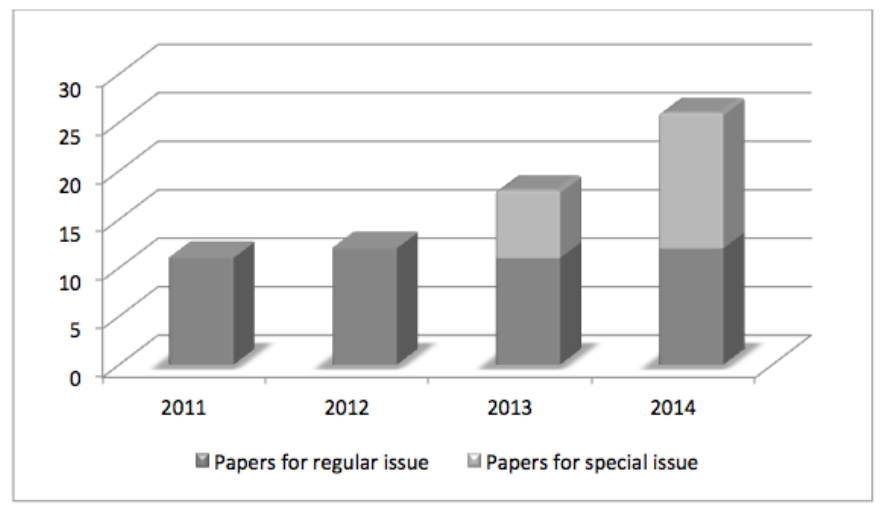
Figure 2. Published papers per year and separately according to regular issue or special